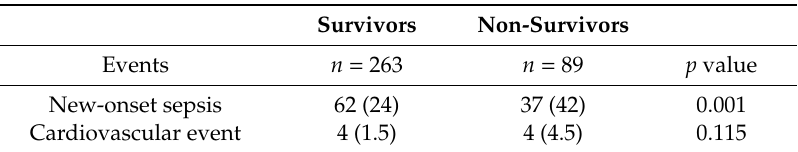
Table 2. Events during the intensive care unit stay.